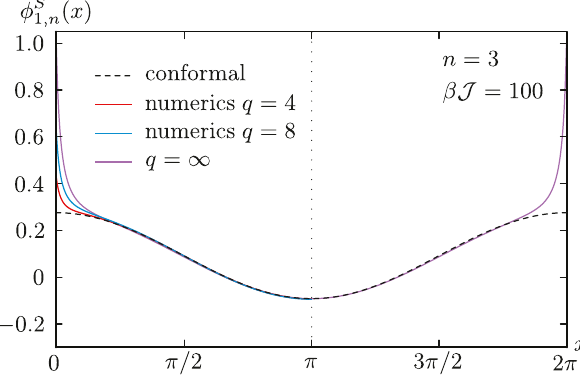
Figure 13. Plot of the wave functions (cid:30) S ( x ) for n = 3, (cid:12) J = 100. The red and blue lines 1 ;n correspond to q = 4 and q = 8 wave functions, obtained by numerical diagonalization of the symmetric kernel (see section 4.3). The dashed line is the conformal function (4.16). The purple line is the large q result